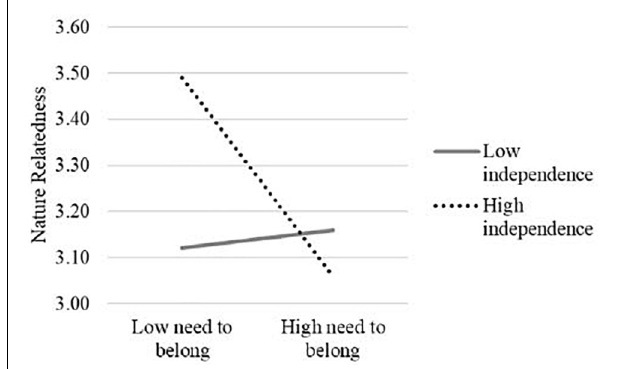
FIGURE 1 | The interaction effect of the need to belong and independence in predicting nature relatedness in Study